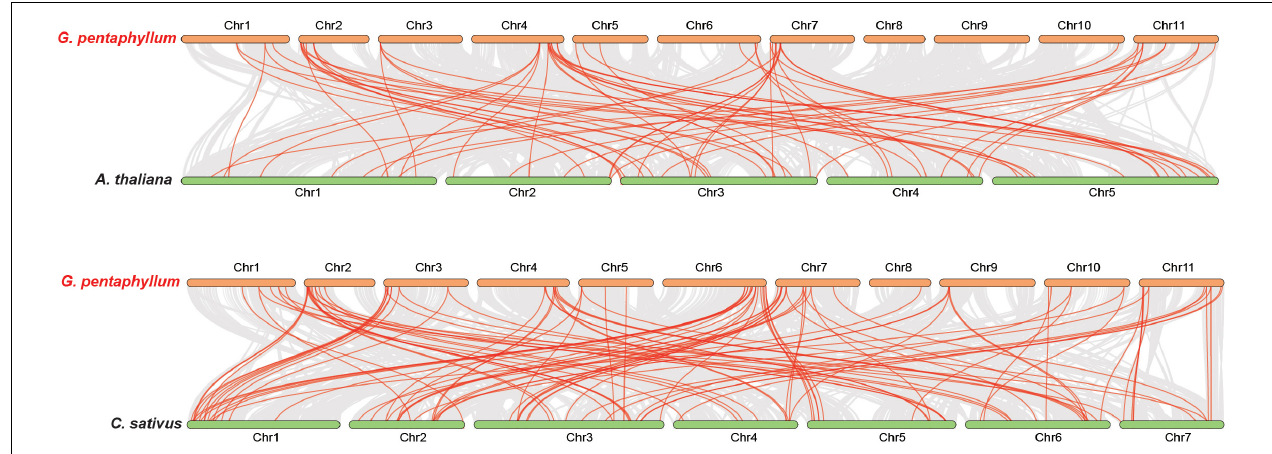
FIGURE 5 | Collinearity analysis of R2R3-MYB genes between G. pentaphyllum and two representative plant species [ A. thaliana and Cucumis sativus ( C. sativus )]. Chr represents chromosome-scale scaffolds. All the gene pairs and syntenic R2R3-MYB gene pairs were presented by gray lines and red lines,